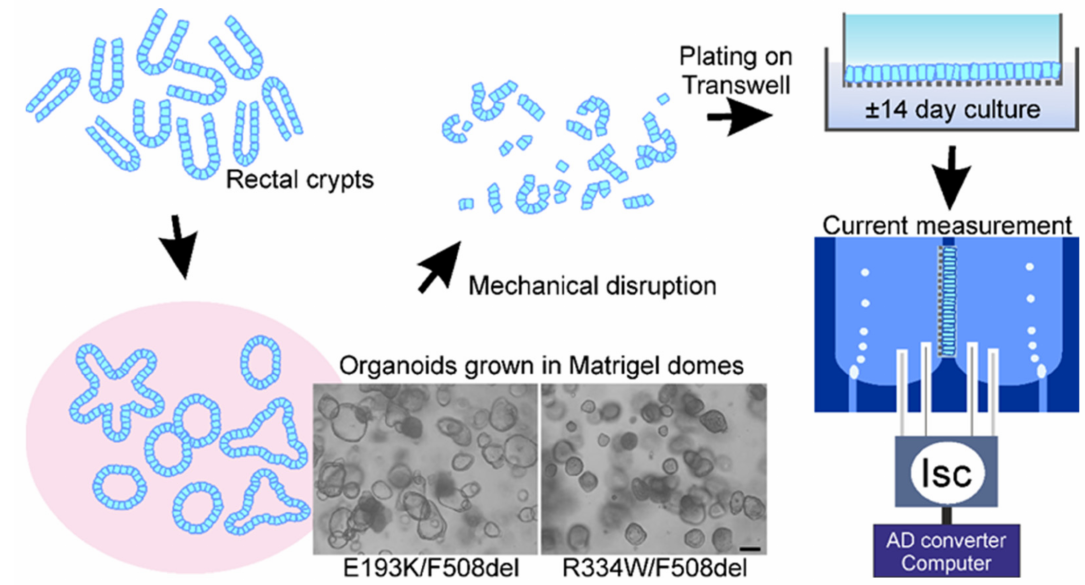
Figure 2. Generation of 3D and 2D human intestinal organoid cultures from rectal